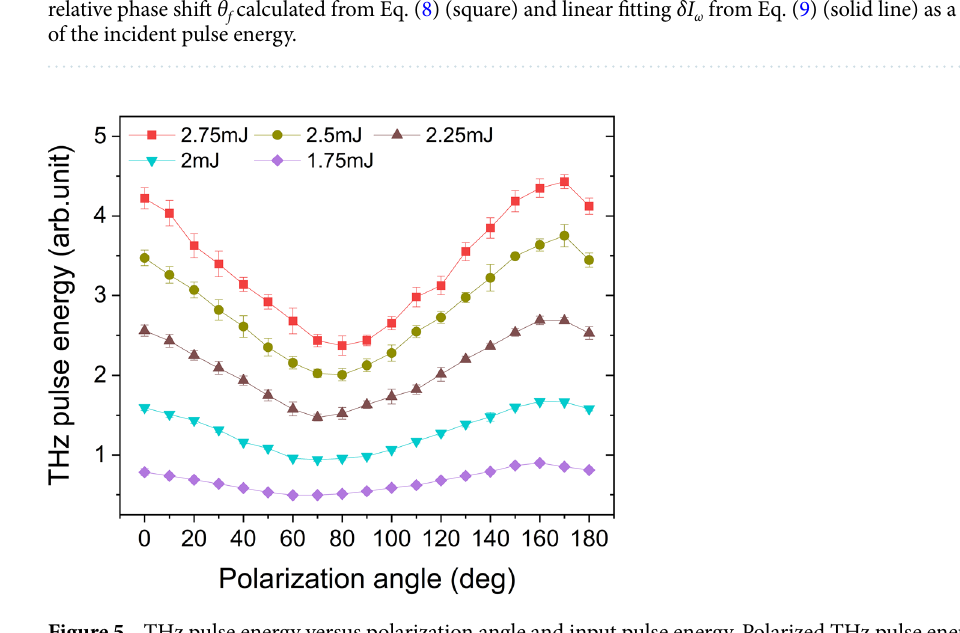
Figure 5. THz pulse energy versus polarization angle and input pulse energy. Polarized THz pulse energy is measured at the corresponding peak position in Fig. 2. The polarization angle is adjusted by a wire grid polarizer in front of the pyroelectric detector. Error bars represent standard deviation of five